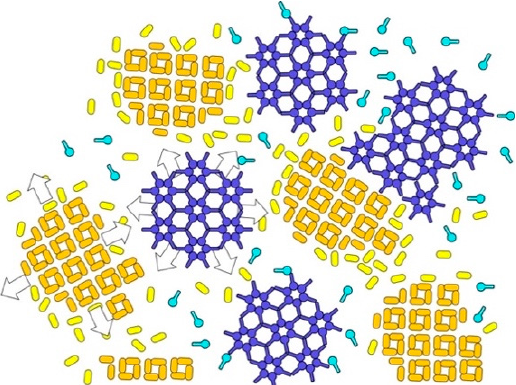
Figure 5. Schematic drawing of the heterologous reassembly of two different S-layer proteins with square and hexagonal lattice symmetry, respectively. According to the non-classical, multi-stage reassembly process, proteins in the crystalline domains have undergone a transformation into compact monomers (orange and dark blue) compared to the extended proteins still in solution or amorphous clusters (yellow and light blue).